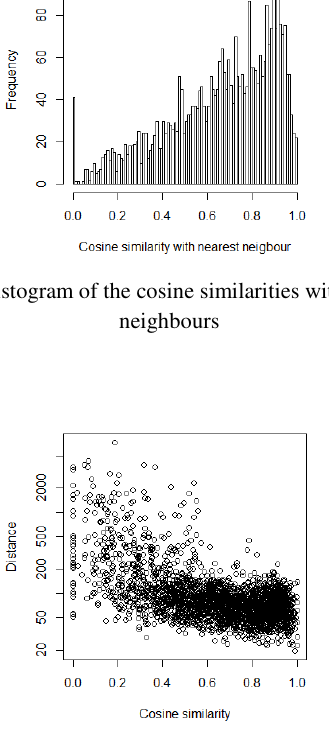
Figure 4: Scatter plot of the cosine similarity and distance of nearest neighbour pairs